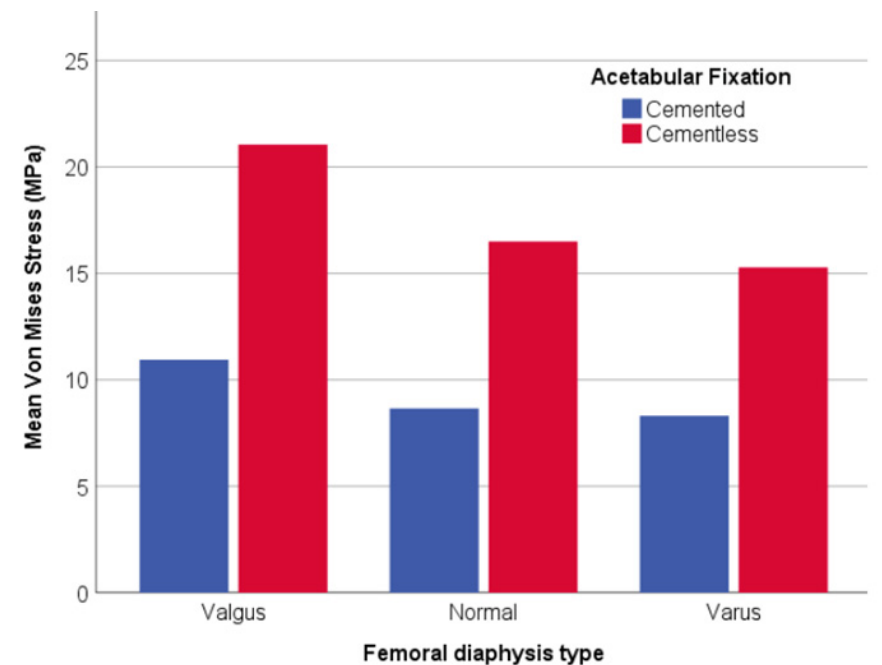
Figure 6. Bar graph with the relationship between VM Stress (MPa) and the femoral diaphysis type.